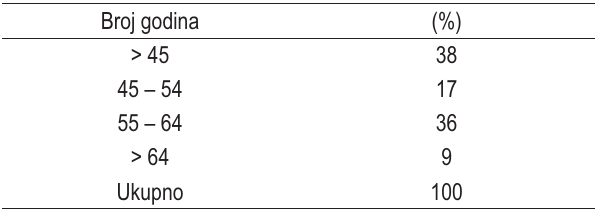
TABELA 1. Starosna zastupljenost